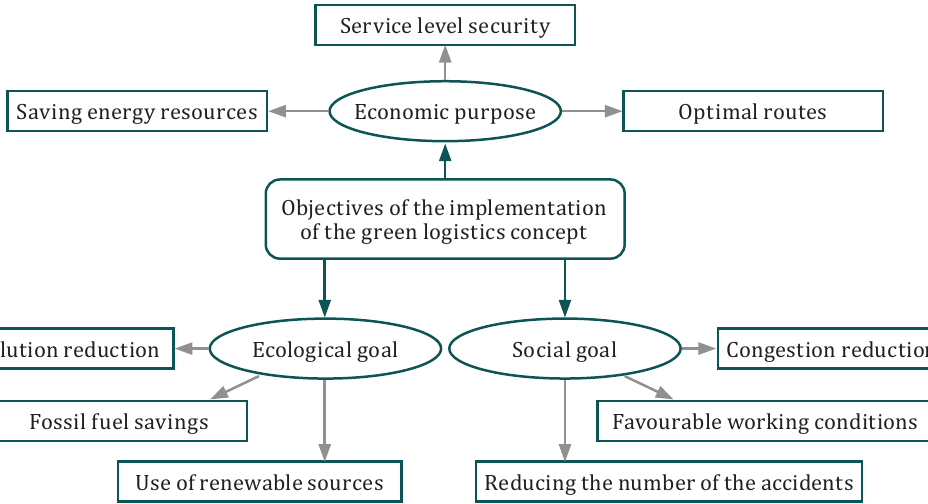
Figure 1. The main goals of the implementation of the concept of green